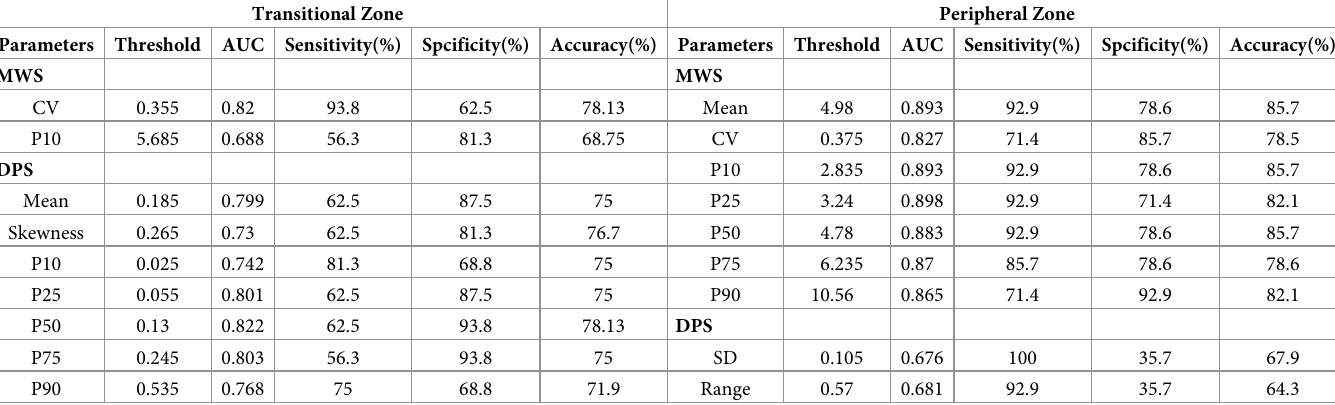
Table 5. The threshold values, AUC, sensitivity, specificity and accuracy of the histogram parameters (10 mm of ROI). Transitional Zone Peripheral Zone